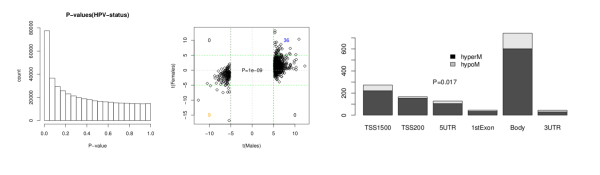
Supervised differential methylation analysis reveals human papillomavirus-positive (HPV+) signature, showing a skew towards hypermethylation. (A) Histogram of P-values from the supervised analysis a clear trend towards small significant P values. (B) Independence of HPV status and sex: scatter plot of t-statistics of individual CpGs reflecting HPV status (positive t-statistics indicate hypermethylation in HPV-infected samples). wiht P value computed using Wilcoxon rank sum test. (C) Methlyation status according to gene-feature annotation, showing a clear trend towards hypermethylation (P = 0.017). Gene features: TSS1500, TSS200, 5' untranslated region (UTR), first exon, gene body, 3' UTR.